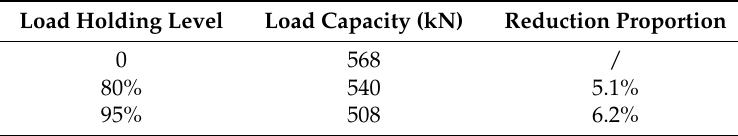
Table 6. Reduction proportion caused by increasing load holding level.